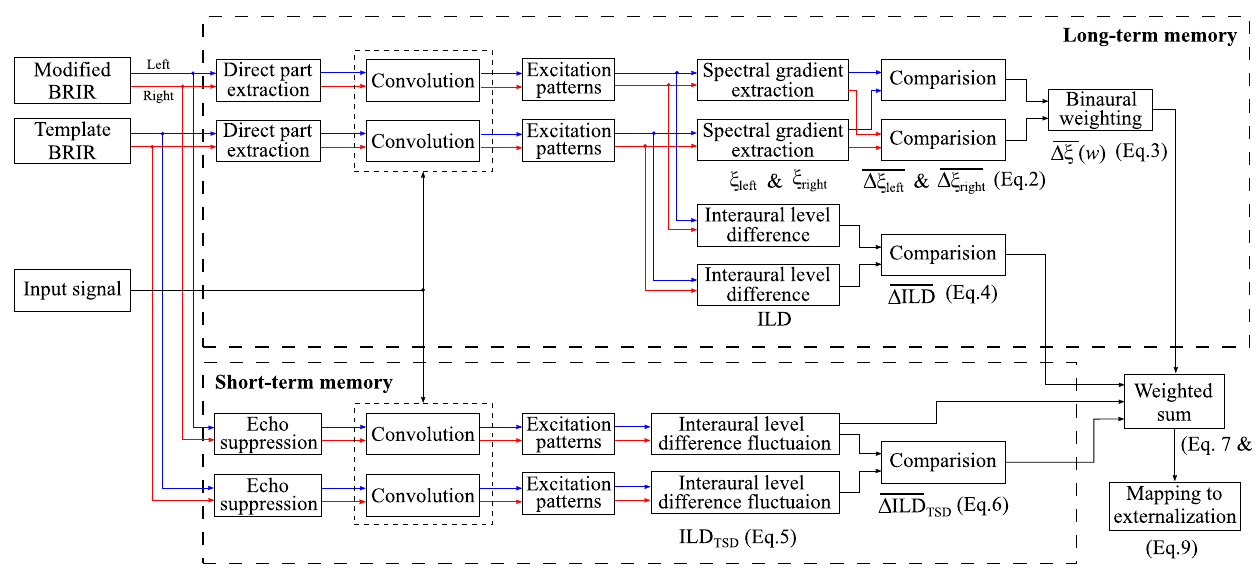
Figure 1. Structure of the proposed externalization model, consisting of a short-term and a long-term memory. In the long-term memory, the spectral gradients and ILDs are extracted from the direct sound part of the target signal in each frequency channel of a gammatone fi lter bank. In the short-term memory, the ILD temporal standard deviations are obtained from the echo-suppressed reverberant signals in each frequency channel. The deviations of these three acoustic cues from the template signals are summed up with different weighting factors and mapped to externalization